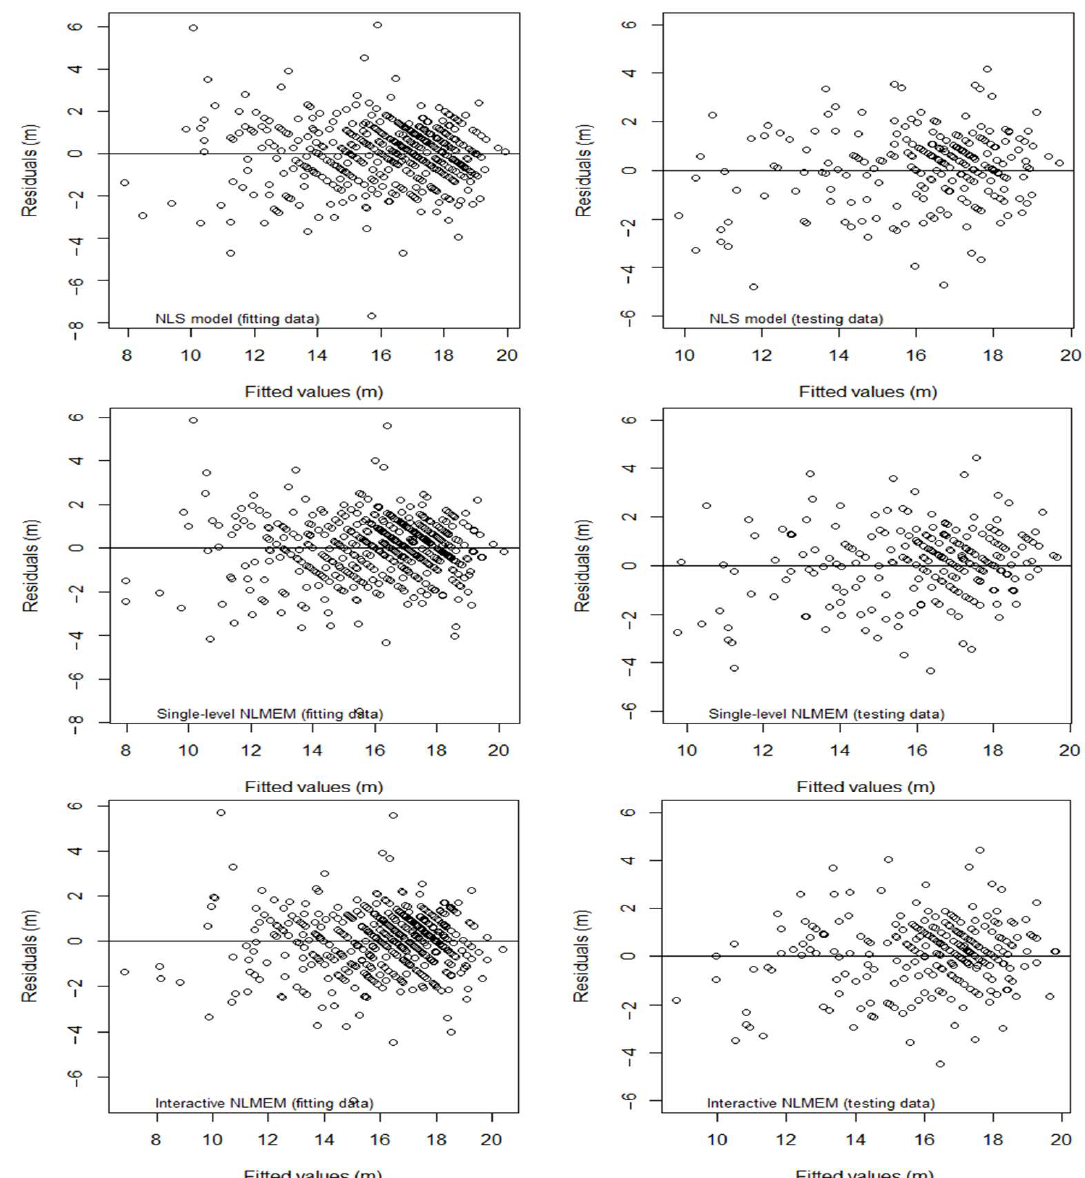
Figure 3. Height-diameter curves produced with Equation (13) corresponding to 14 combinations of M ∗ S (stand density ∗ site index; 3 ∗ 2= stand density is class 3 and site index is class 2). The left is the height-diameter curves superimposed on the model fitting data, and the right is the height-diameter curves superimposed on the model testing data.